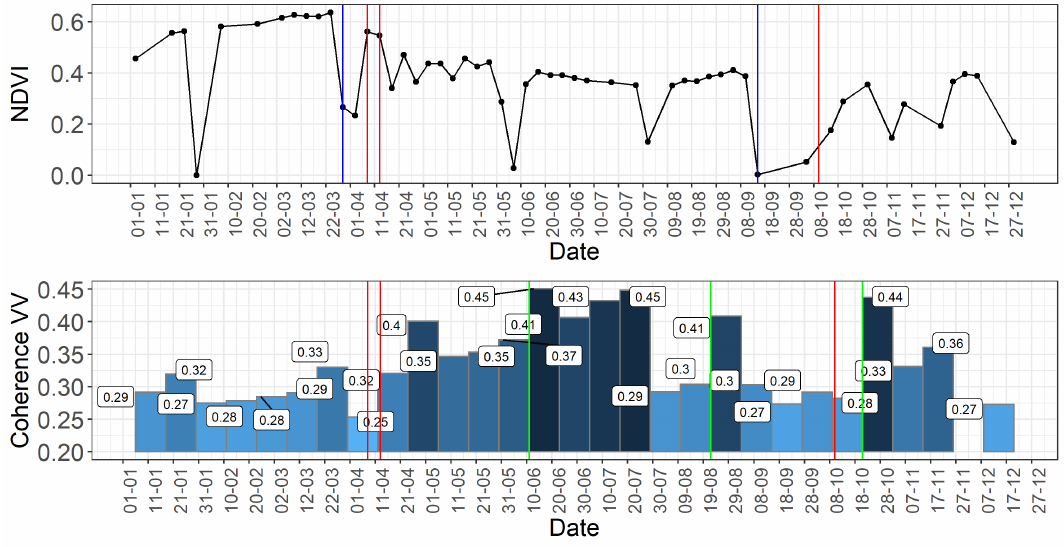
Figure 24. Example of the harvest date omission and false response of the SAR algorithm for a nonhomogeneous parcel (cid = 29). Actual harvest dates (red lines): 8 April 2018, 13 April 2018, and 10 October 2018, 7 July 2018; harvest dates according to the optical algorithm (blue lines): 29 March